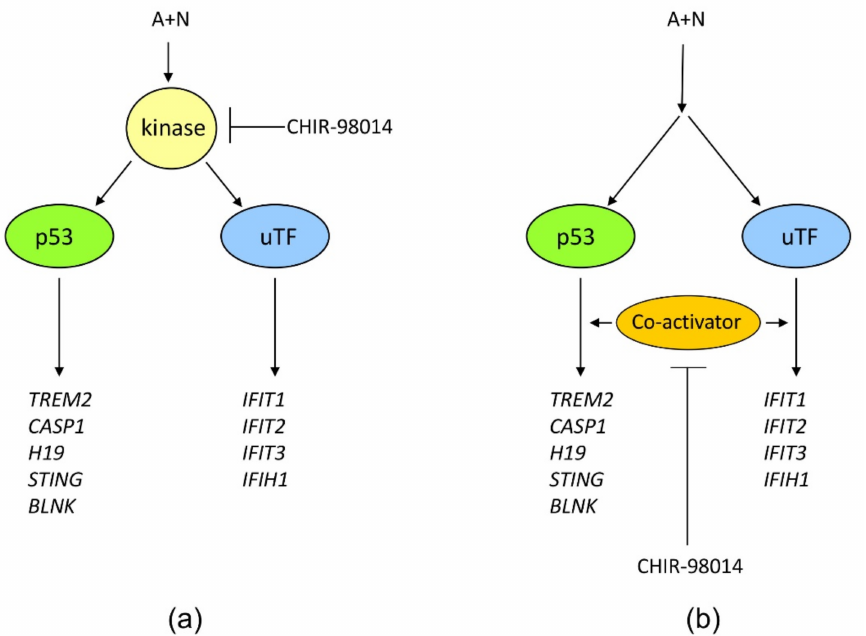
Figure 13. A schematic representation of the two hypotheses ( a , b ) generated by the data presented in this paper. There are two groups of innate immunity genes activated by A + N − one group is stimulated by p53 and the other is activated independently from p53. The other group must be under the control of a transcription factor, which is currently unidentified (uTF). The outcome of activity of both transcription regulators (p53 and uTF) is modulated by a kinase inhibited by CHIR-98014. This kinase plays crucial role in gene regulation in stress conditions elicited by A + N. In principle, the kinase can act upstream ( a ) or downstream ( b ) from p53 or